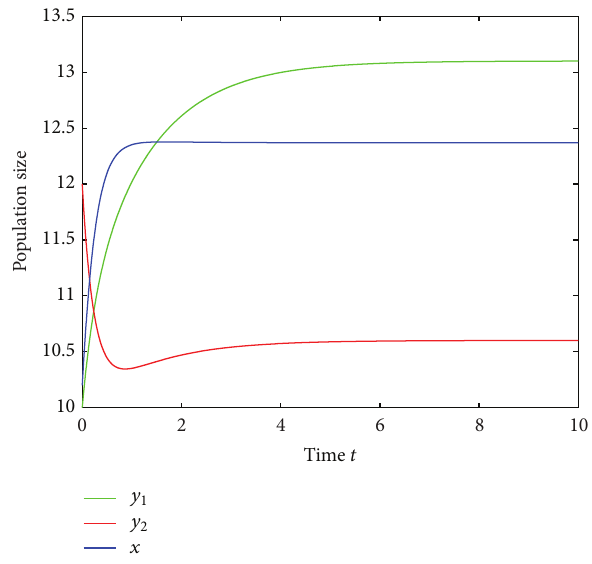
Figure 1: The solution of (2) with initial values 𝑥(0) = 10 , 𝑦 1 (0) = (0) = 12 10 , 𝑦 2